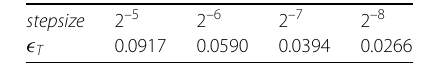
Table 2 Computational error at endpoint T = 1 for Example 5.2